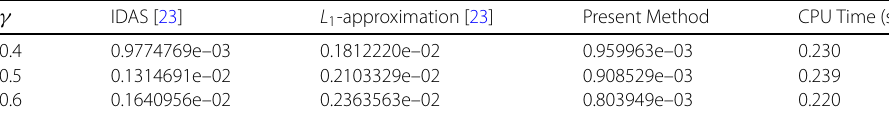
Table 6 The maximum errors when τ = 1 γ